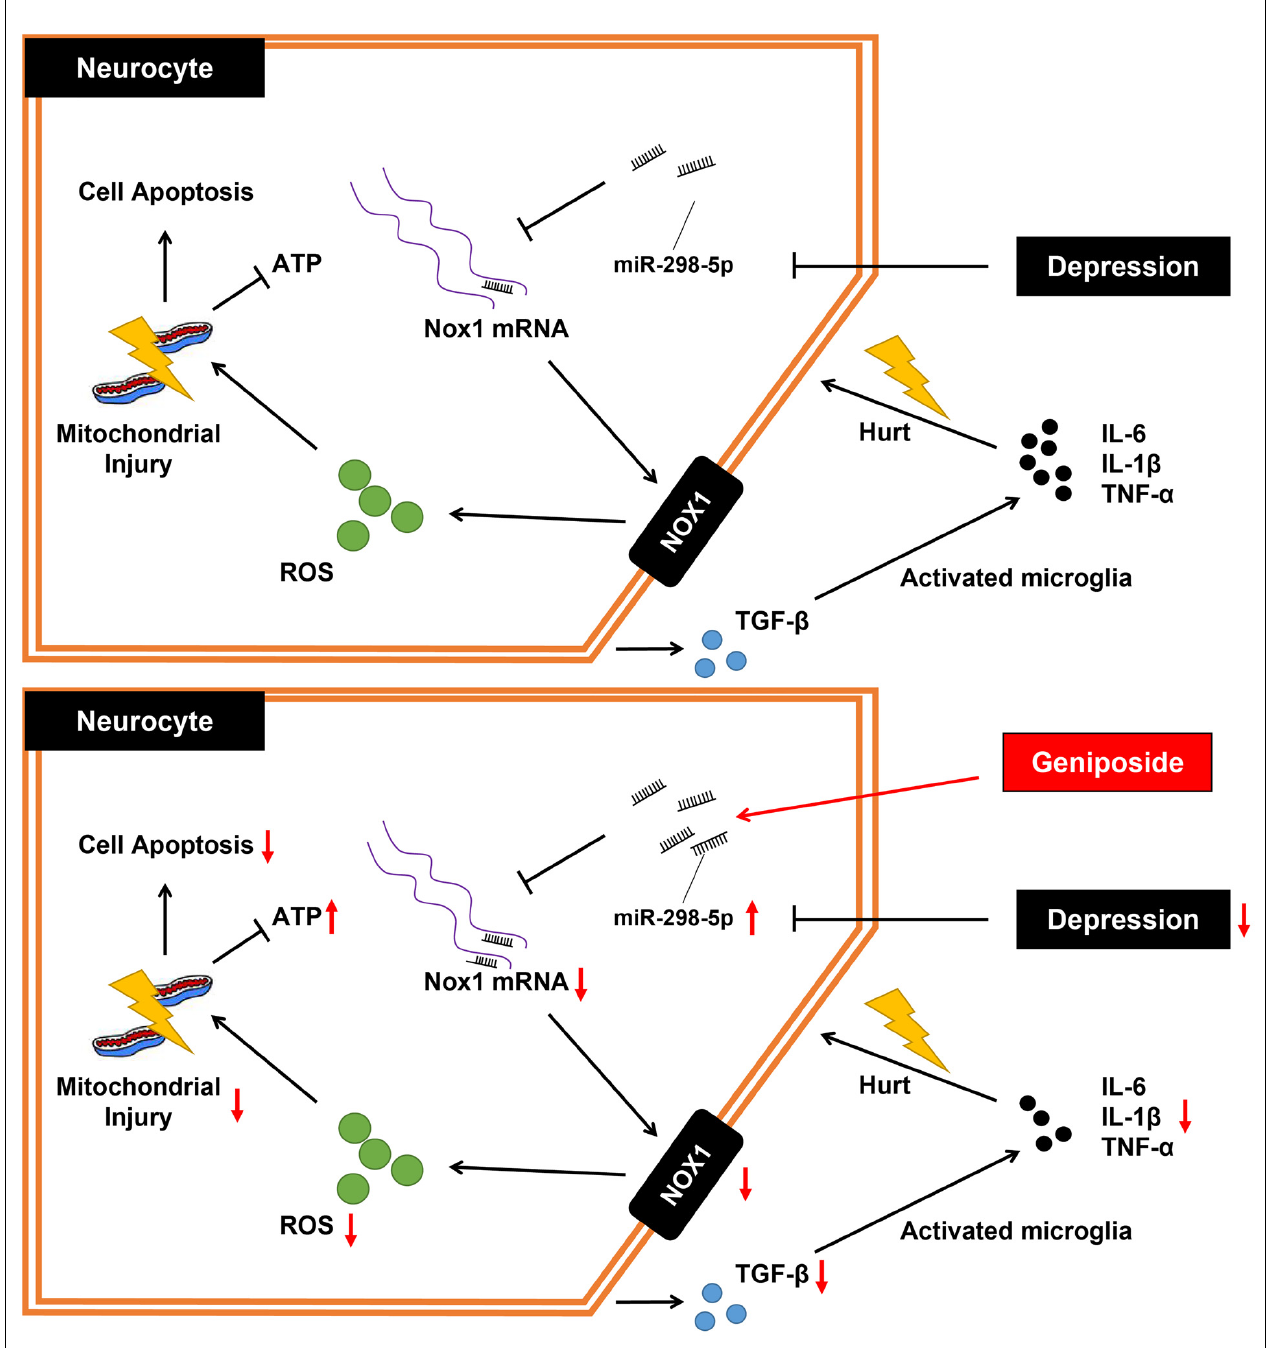
FIGURE 4 | The mechanistic diagram of how geniposide regulated the miR-298-5p/Nox1 axis in alleviating depression-like behavior. Without geniposide treatment, mice with depression-like behavior might show more signs of inflammation. Geniposide treatment can alleviate depression in mice by increasing miR-298-5p expression but reducing Nox1 expression, ROS production, mitochondrial damage, and inflammatory responses.